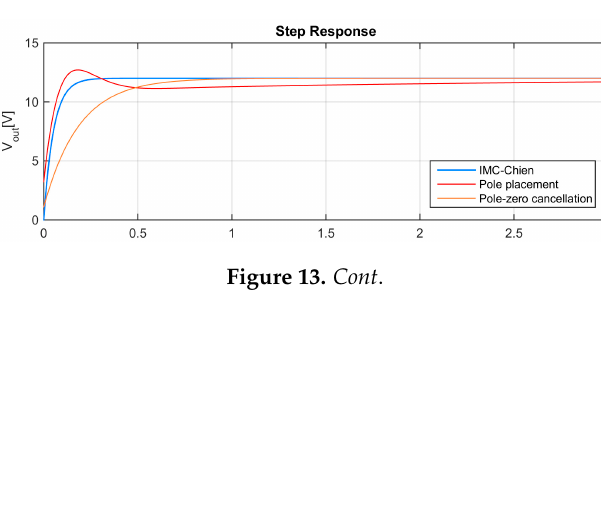
Table 2. PID parameters.